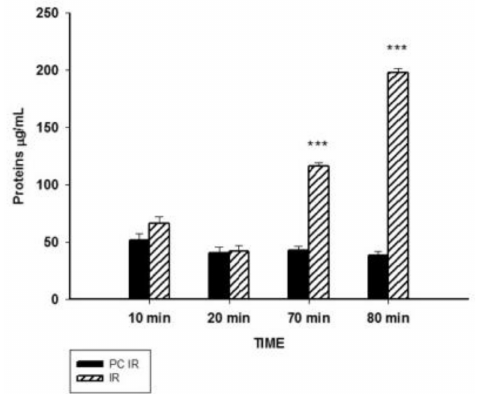
Figure 3. Effect of hypothermic perfusion on cellular integrity. Total protein content in the perfusate. Data is mean ± SEM of six animals. Significantly different from corresponding PC IR values by Student’s t test: *** p <